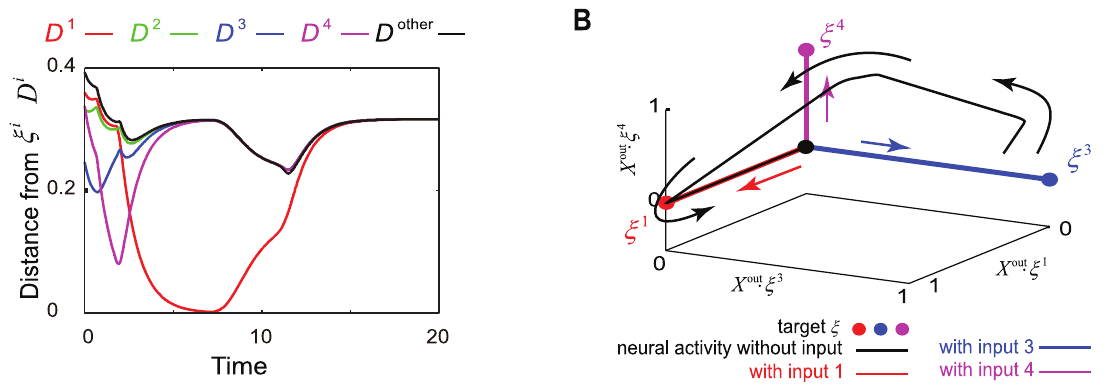
Figure 7. Temporal evolution of neural activity in the case of fixed point. The spontaneous neural dynamics and the evoked one after four I/O mappings are learned are plotted. A) The time courses of the distance between the neural activity of the output and each target are plotted. Here, only the time courses representing the neural dynamics in the absence of input are plotted. The distance is defined as D n ~ j X out { j n j 2 = N , The curves in different colors represent the distance from each target, while the black curve shows the distance from an unlearned target pattern, for reference. B) Neural activity in the output layer is represented as a point in the three-dimensional space and is projected from the N -dimensional space consisting of neural activities in the output layer by obtaining the product of the output activity and the target pattern(s). Each axis represents the product of neural activity and the corresponding target pattern, defined by axis1= X out : j 1 , axis2= X out : j 3 , and axis3= X out : j 4 . The orbits of neural activities after learning I/O mappings are plotted. The black line and circle represent a transient trajectory and a fixed-point attractor in the absence of inputs, respectively. The colored (red, green, and blue) lines and circles represent the trajectories and fixed-point attractors in the presence of inputs, respectively, with each color indicating the corresponding input. In the absence of an input, the neural activity once approaches some fixed point corresponding to the given target outputs and then departs, before finally converging to the fixed-point attractor. Upon the application of an input, the fixed-point attractor becomes unstable, and hence, the neural activity is attracted to a new fixed point, thereby giving rise to a target output corresponding to the input.